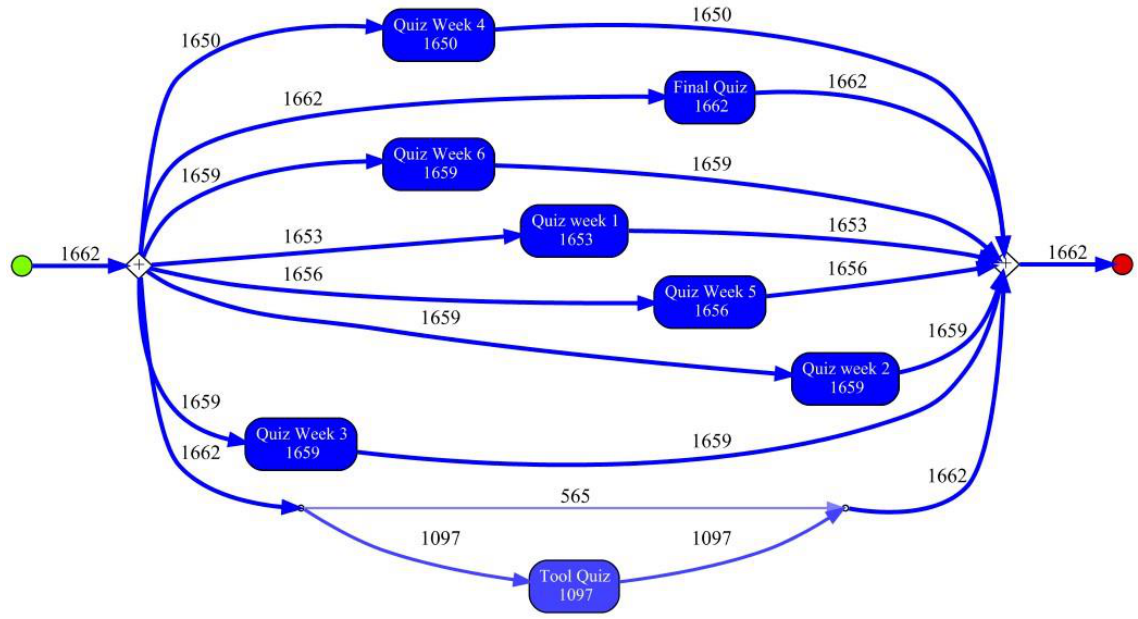
Figure 5 . Quiz submission behaviour of students that obtained a